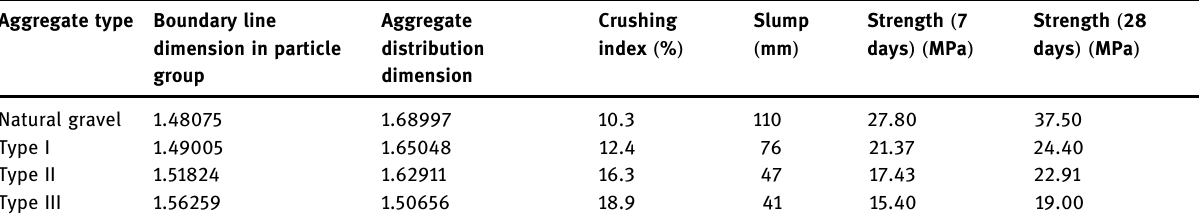
Table 10: Performance indicators of varied sands Aggregate type Boundary